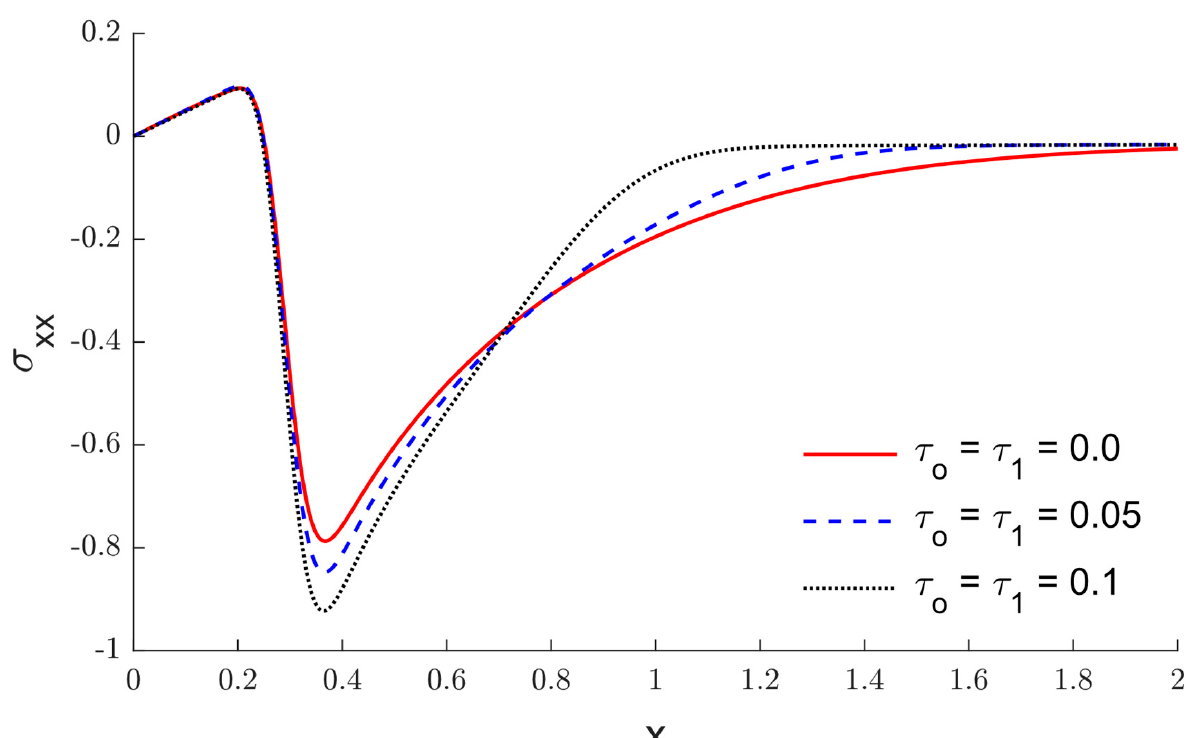
Figure 9. The impact of thermal relaxation times τ o , τ 1 in the stress variation σ xx via the distance x when K n = 0.5 .